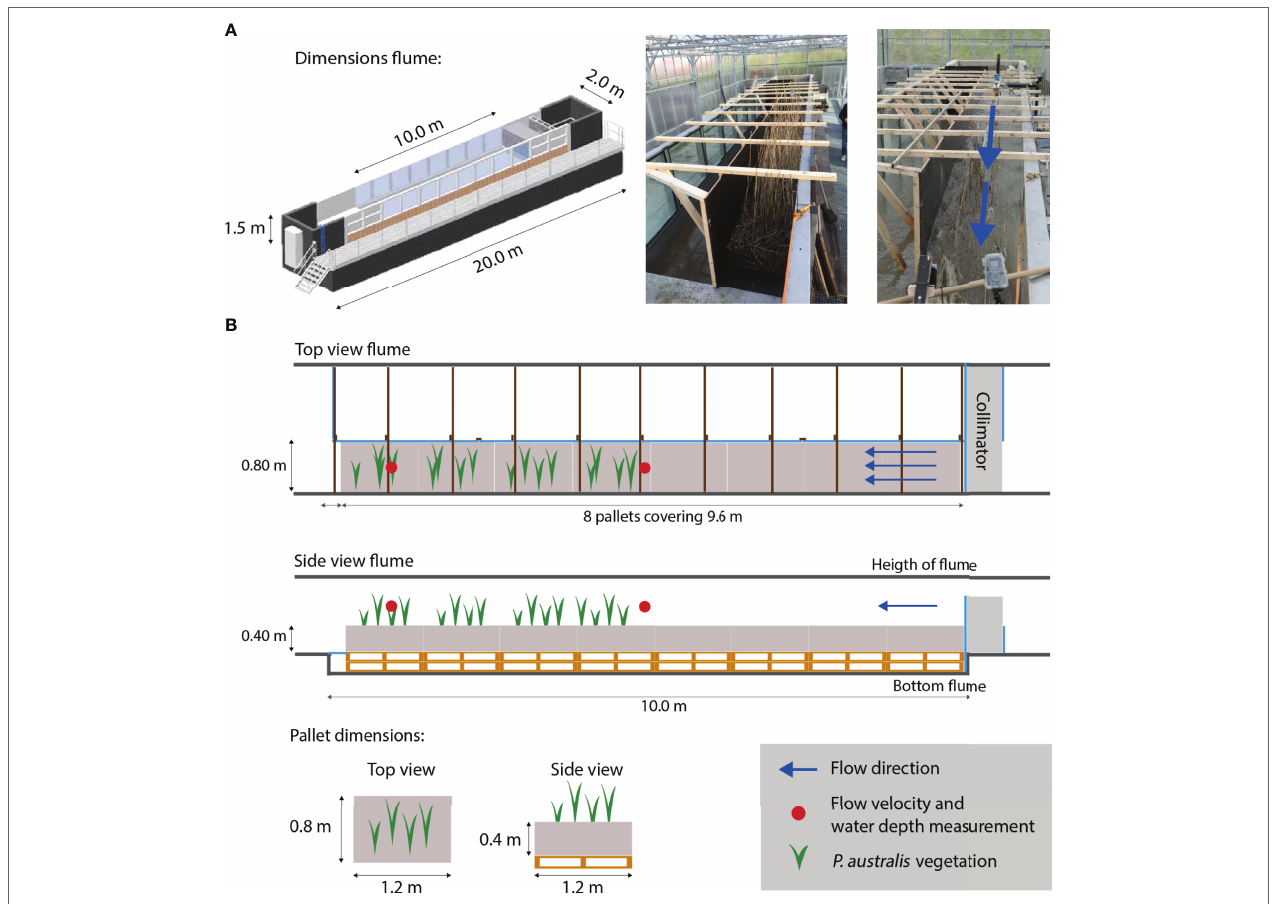
FIGURE 2 | Overview of the flume dimensions and experimental setup (A) . Schematic top view and side view of the experimental setup in the flume (B) . The flow is generated by a pump that forces water through a collimator into the 0.80 m wide test section. Uniform flow was created by removal of the aboveground vegetation in the first meters of the test